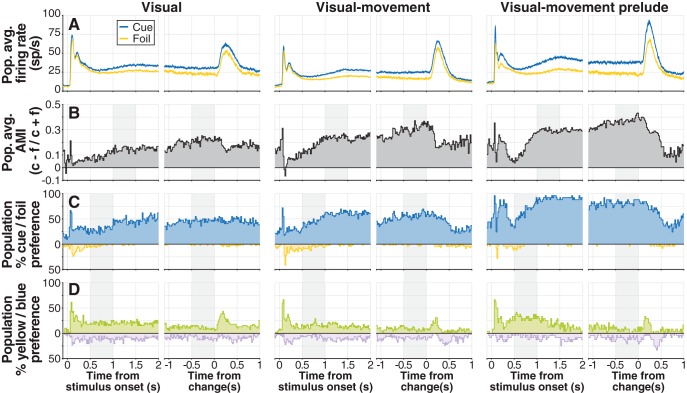
The strength of cue-related modulation varies by unit-type category in distinct ways from color-related modulation. A, Population average firing rates for cued stimulus (blue) and foil (yellow) aligned on stimulus onset (left) and change (right), for V (n = 42; far left), VM (n = 45; middle), and VMp (n = 46; far right) categories. B, Population average AMI by category: for each unit, average spike count in nonoverlapping 20 ms bins for the cued stimulus (c) and the foil stimulus (f) was used to calculate AMI = (c − f)/(c + f); individual AMIs were then averaged to obtain population AMI. Gray shaded regions mark time windows used for ANOVA (see Results). C, Population-level percentage cue/foil preference by category: the percentage of units in each bin with significantly larger spike counts for the cue (blue) or the foil (yellow); significance was determined with bootstrapped ROC area. Shaded regions indicate time windows used for ANCOVA. D, Population-level percentage yellow/blue preference by category: the percentage of units in each bin with significantly larger spike counts for the yellow or the blue stimulus determined with bootstrapped ROC area. Because of the similarity of individual neuron responses to increases and decreases, data from increase trials and decrease trials were pooled.